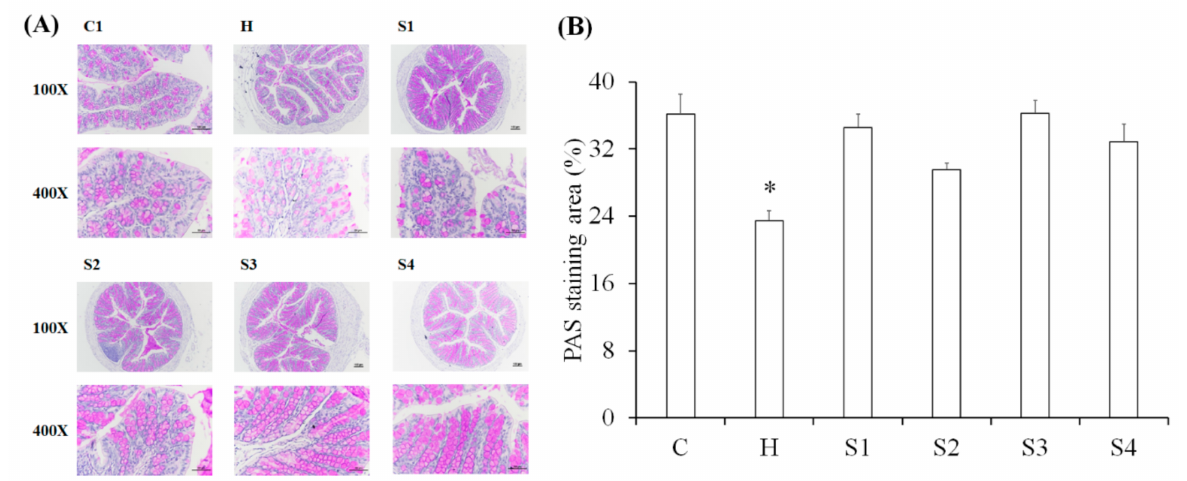
Figure 6. Periodic acid-Schiff staining (PAS) staining in the colon of mice. ( A ) Representative PAS stained sections. ( B ) Quantification of PAS staining. Data are shown as means ± SEM ( n = 5). * p < 0.05 compared to the control